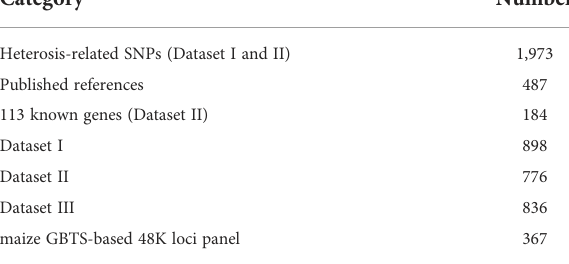
TABLE 1 The number of target SNPs selected from different